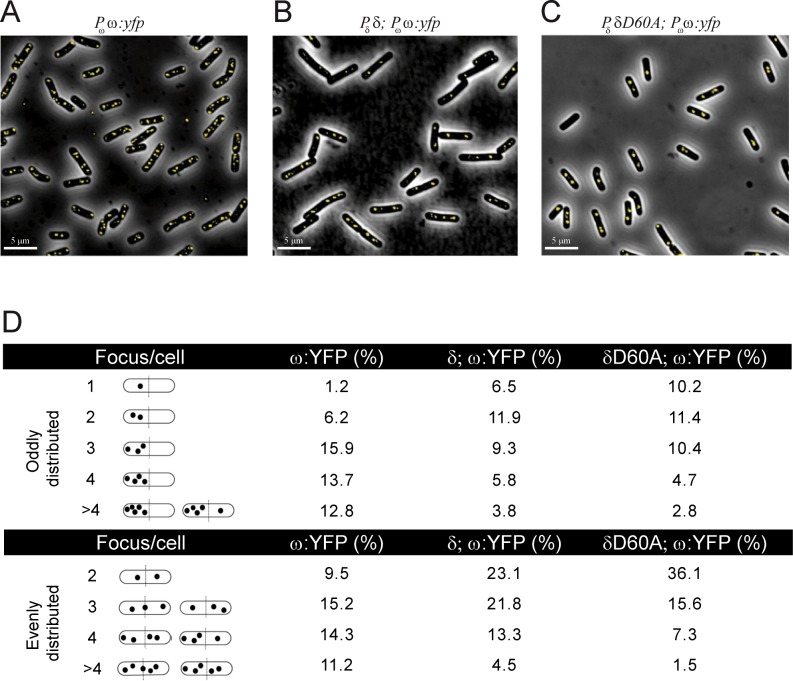
Subcellular position of (ω:YFP)2 foci in the absence or in the presence of δ2 or δ2D60A.Cells bearing plasmid-borne P
ω ω:yfp (A), P
δ δ and P
ω ω:yfp (B) or P
δ δD60A and P
ω ω:yfp genes (C) were grown in MMS7 at 30°C. YFP fluorescence of a typical field of each situation is presented. Scale bar is 5 μm. (D) The oddly or evenly distributed foci (1 to more than 4 foci) are shown schematically. The percentages of (ω:YFP)2 foci at each position around the cell center in the different conditions are indicated (calculated from >2,000 cells).